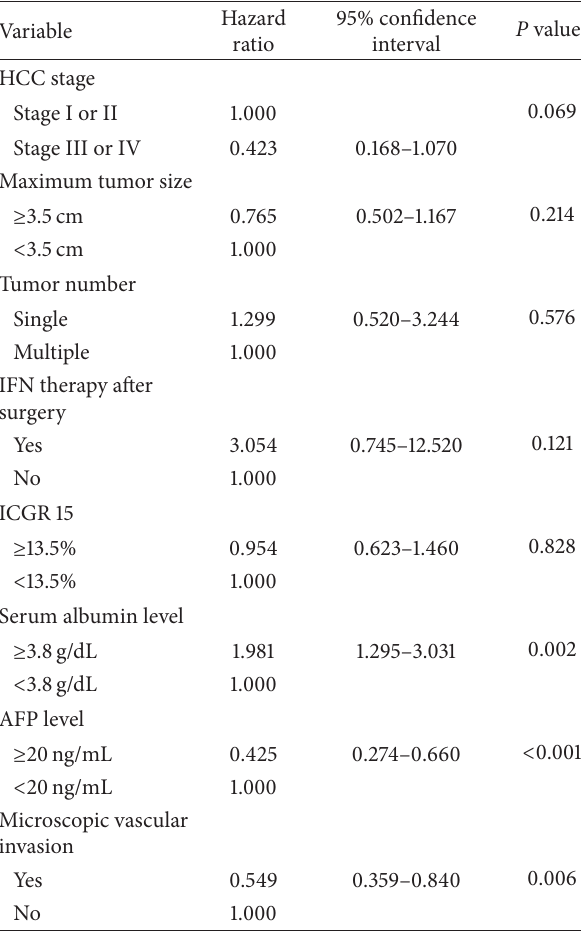
Table 3: Multivariate analysis associated with OS after surgical resection for hepatocellular